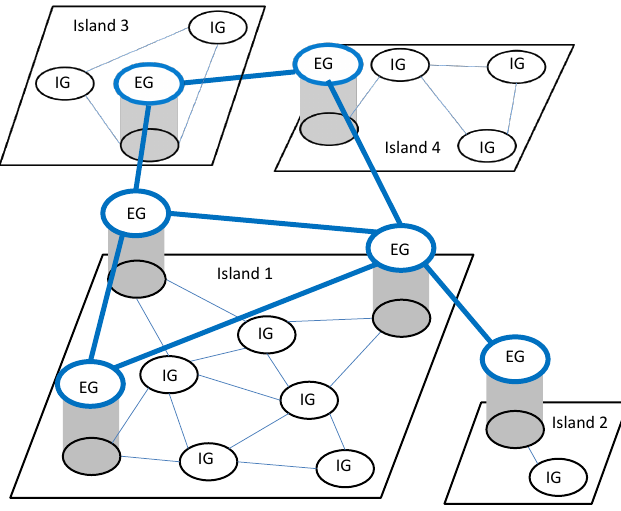
Figure 1. A layered federated sensor network